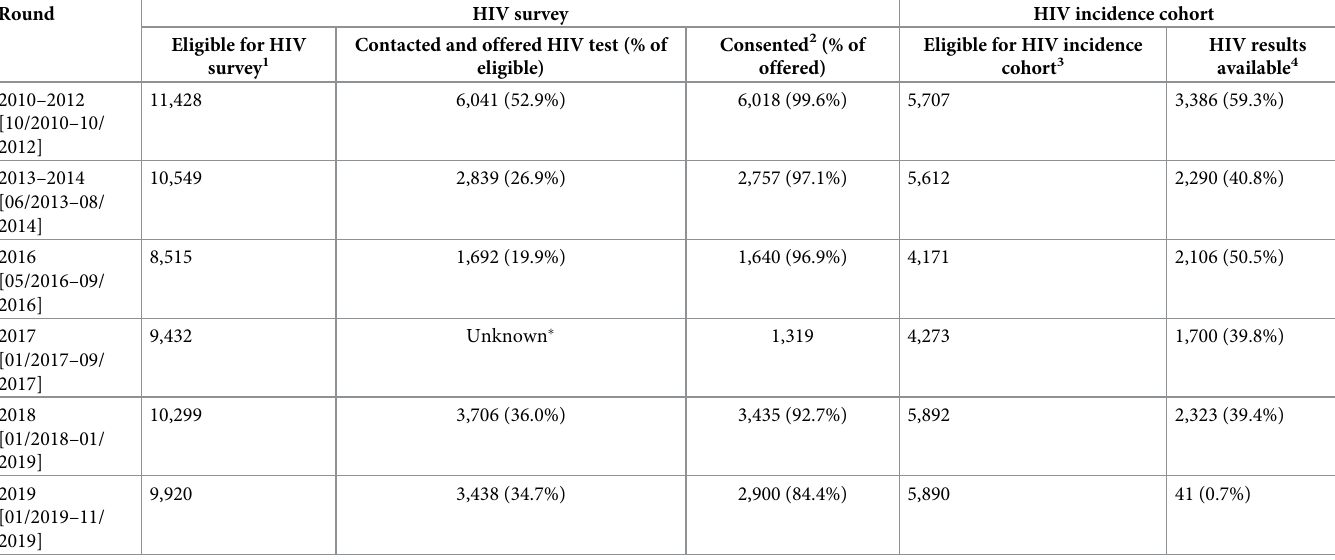
Table 2. Testing participation in HIV serosurveys among AGYW and contribution to HIV incidence cohort in uMkhanyakude, South Africa (A) and Gem, Kenya